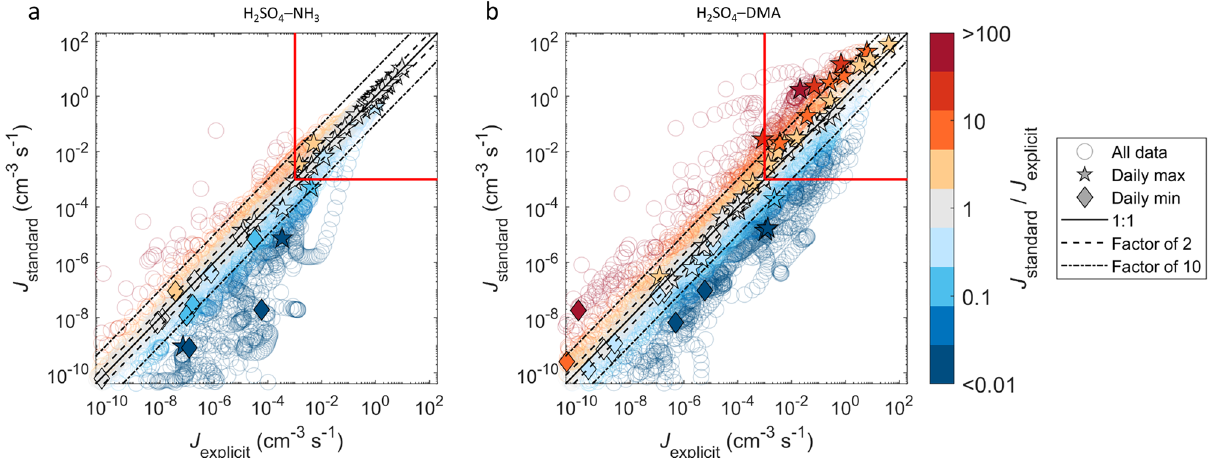
Figure 3. Particle formation rates for the standard and explicit cases for all trajectories with the formation process driven by H 2 SO 4 –NH 3 ( a ), and H 2 SO 4 –DMA ( b ). The color scale gives the ratio between the standard and explicit cases. The lower limits of the axes are set to 10 −10 cm −3 s −1 to exclude rates that are close to zero, and the red rectangles mark the region of atmospherically significant formation rates of ≥ 10 −3 cm −3 s −1